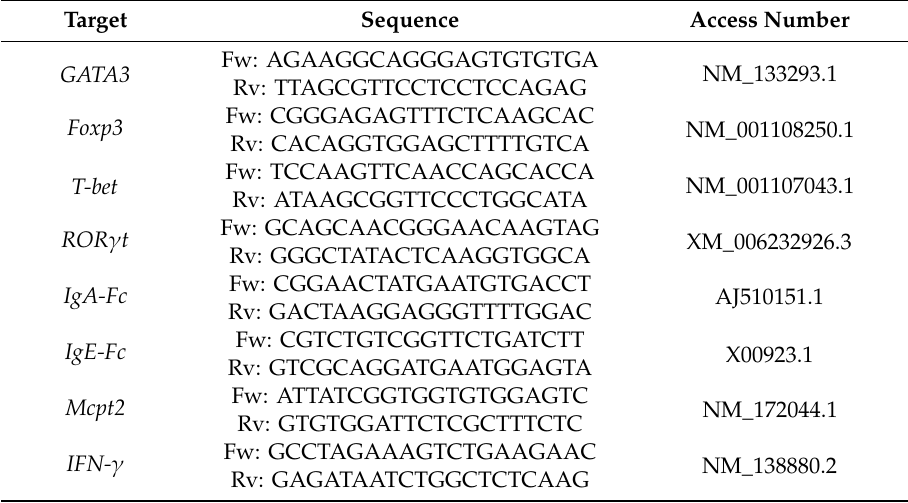
Table 1. Primers used in this